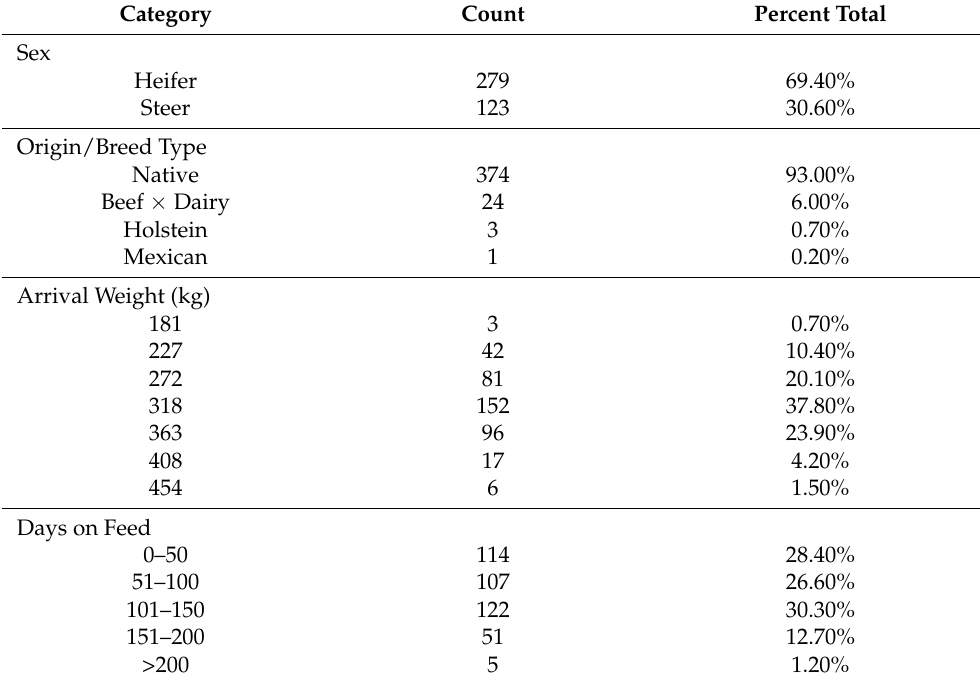
Table 1. Descriptive table of cattle demographics for mortalities evaluated in this study.